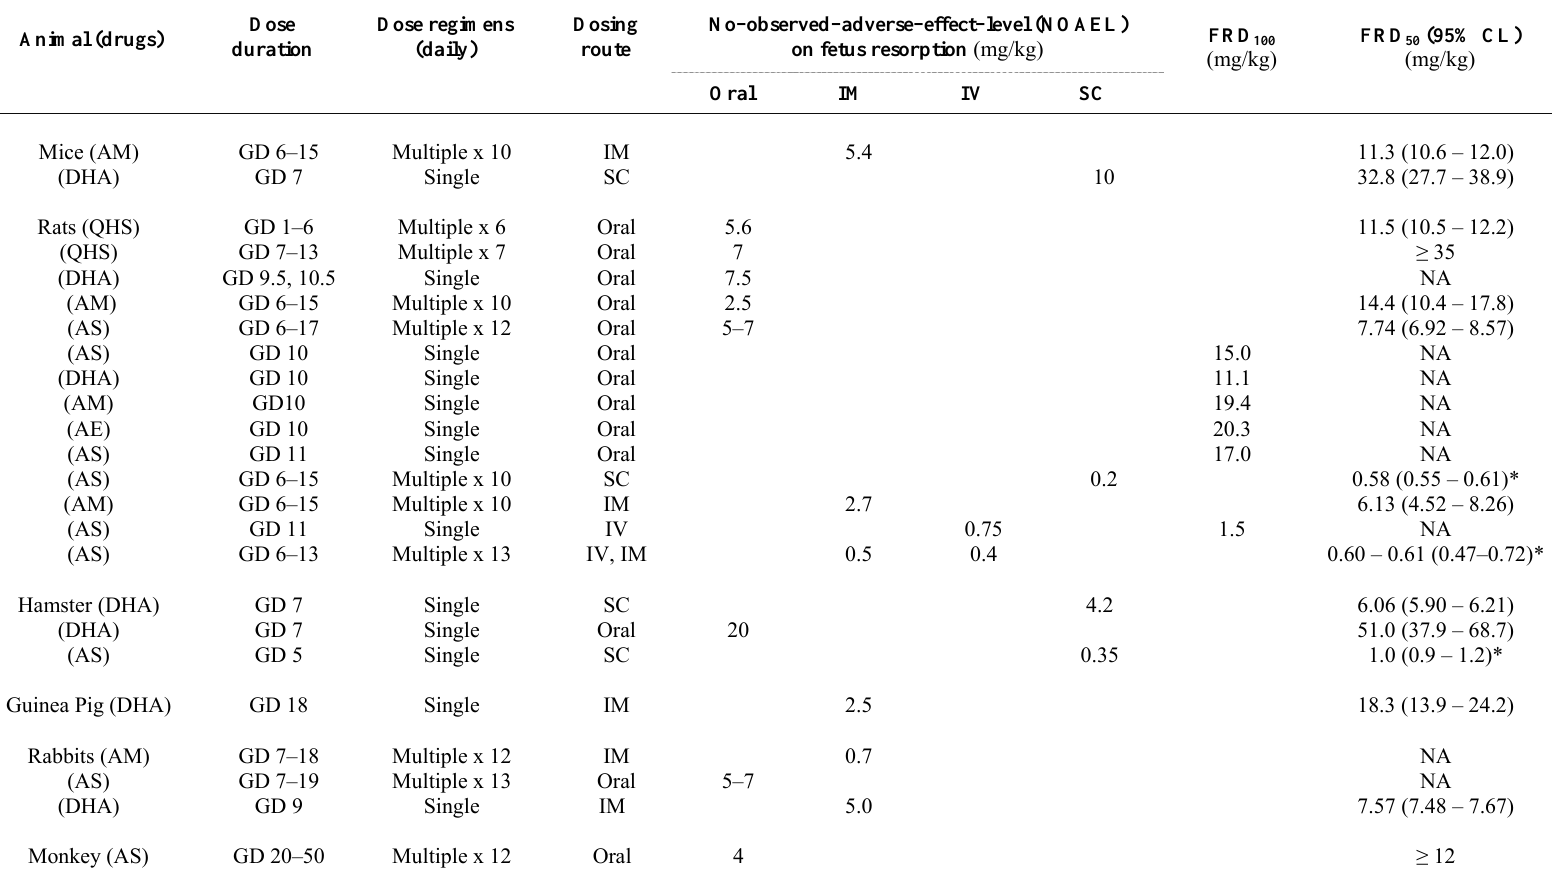
Table 1. Embryotoxic effects (NOAEL and FRD ) of artemisinin (QHS), dihydroartemisinin (DHA), artesunate (AS), artemether (AM) 50 or 100 and arteether (AE), given intragastrically (Oral), intravenously (IV), intramuscularly (IM), and subcutaneously (SC) in pregnant mice, rats, hamster, guinea pig, rabbits, and monkeys